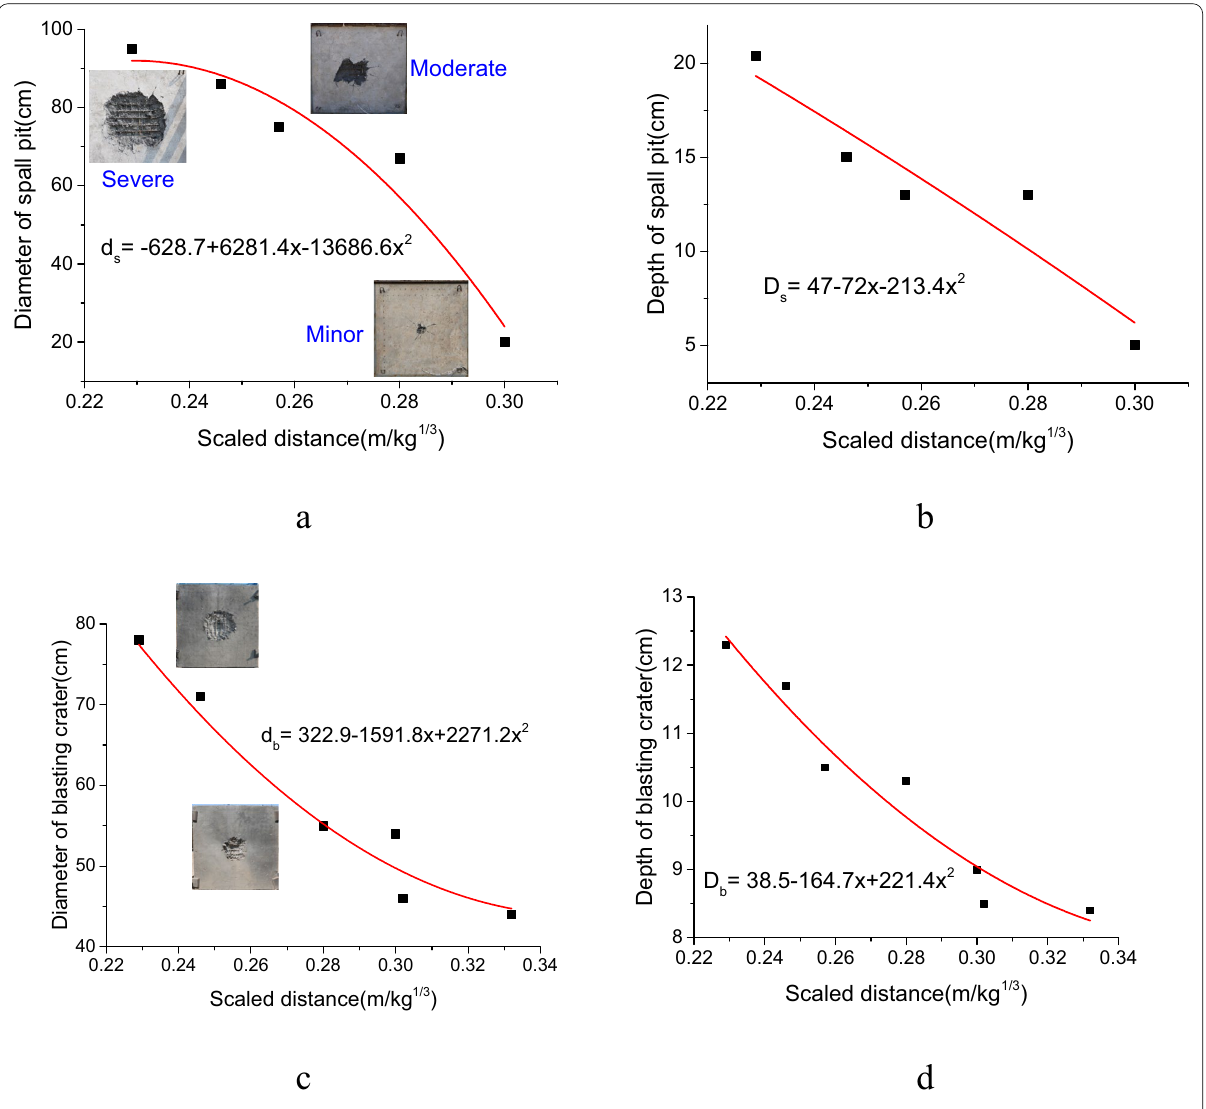
Fig. 15 The relationship between scaled distance and: a diameter of spall pit; b depth of spall pit; c diameter of blasting crater; and d depth of blasting